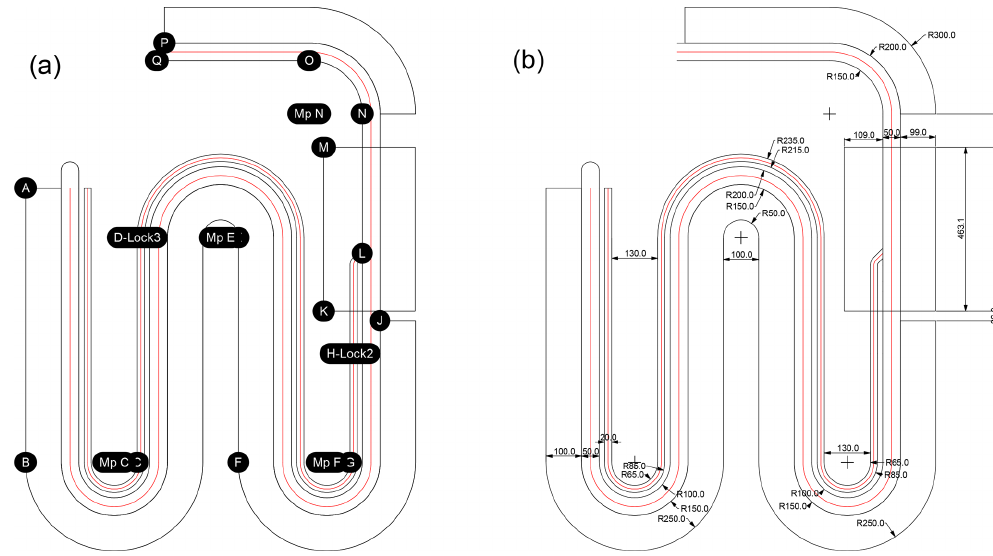
Figure B1. Drawings of the basic topographic landscape of Wetropolis with letter indications (a) matching coordinates (b) .